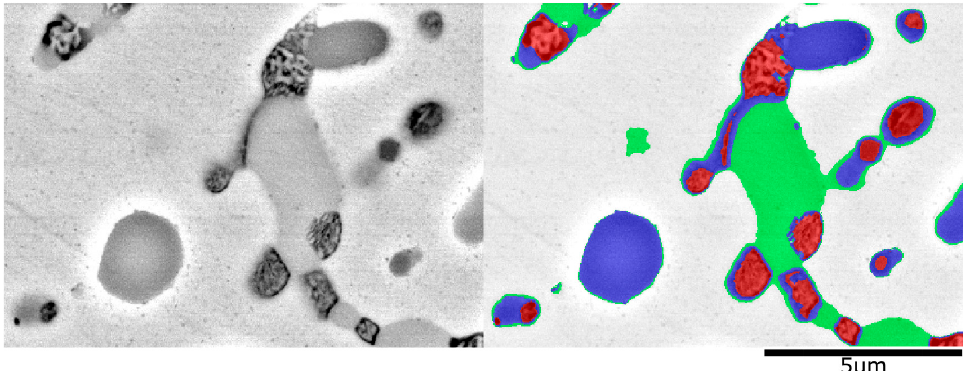
Figure 9. Segmentation and classification (a detail section from a Zoom4000, 3% Sn